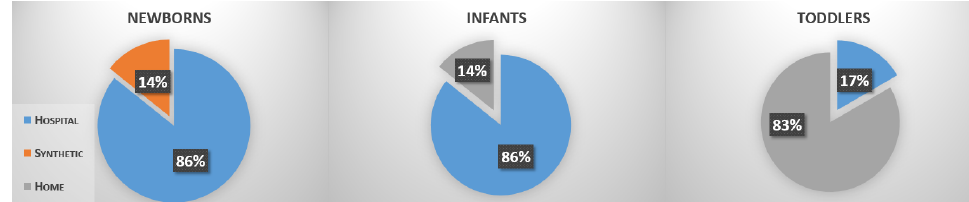
Figure 3. Percentages of published papers with respect to setup taxonomy (home, hospital,